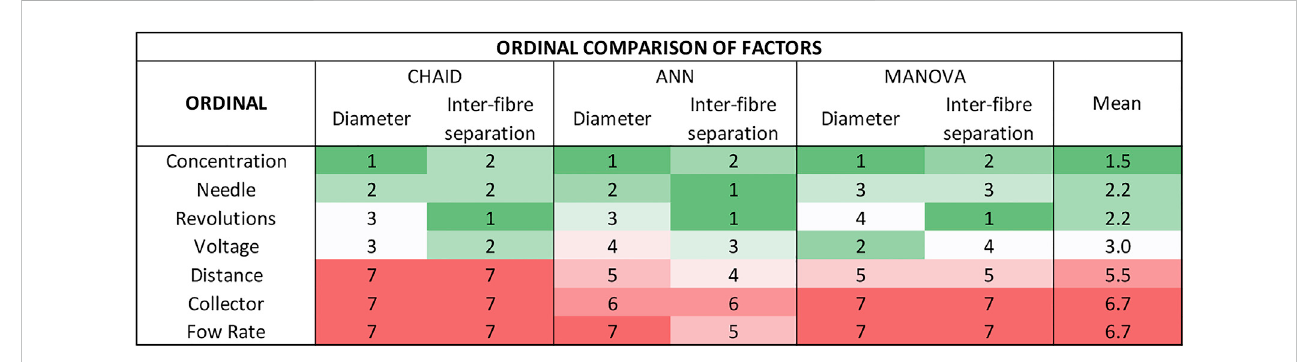
FIGURE 7 CHAID vs. MANOVA vs. ANN: ordinal importance of each factor to predict both diameter of the fi bres and inter- fi bre separation (1 is the most important factor and 7 is the least important